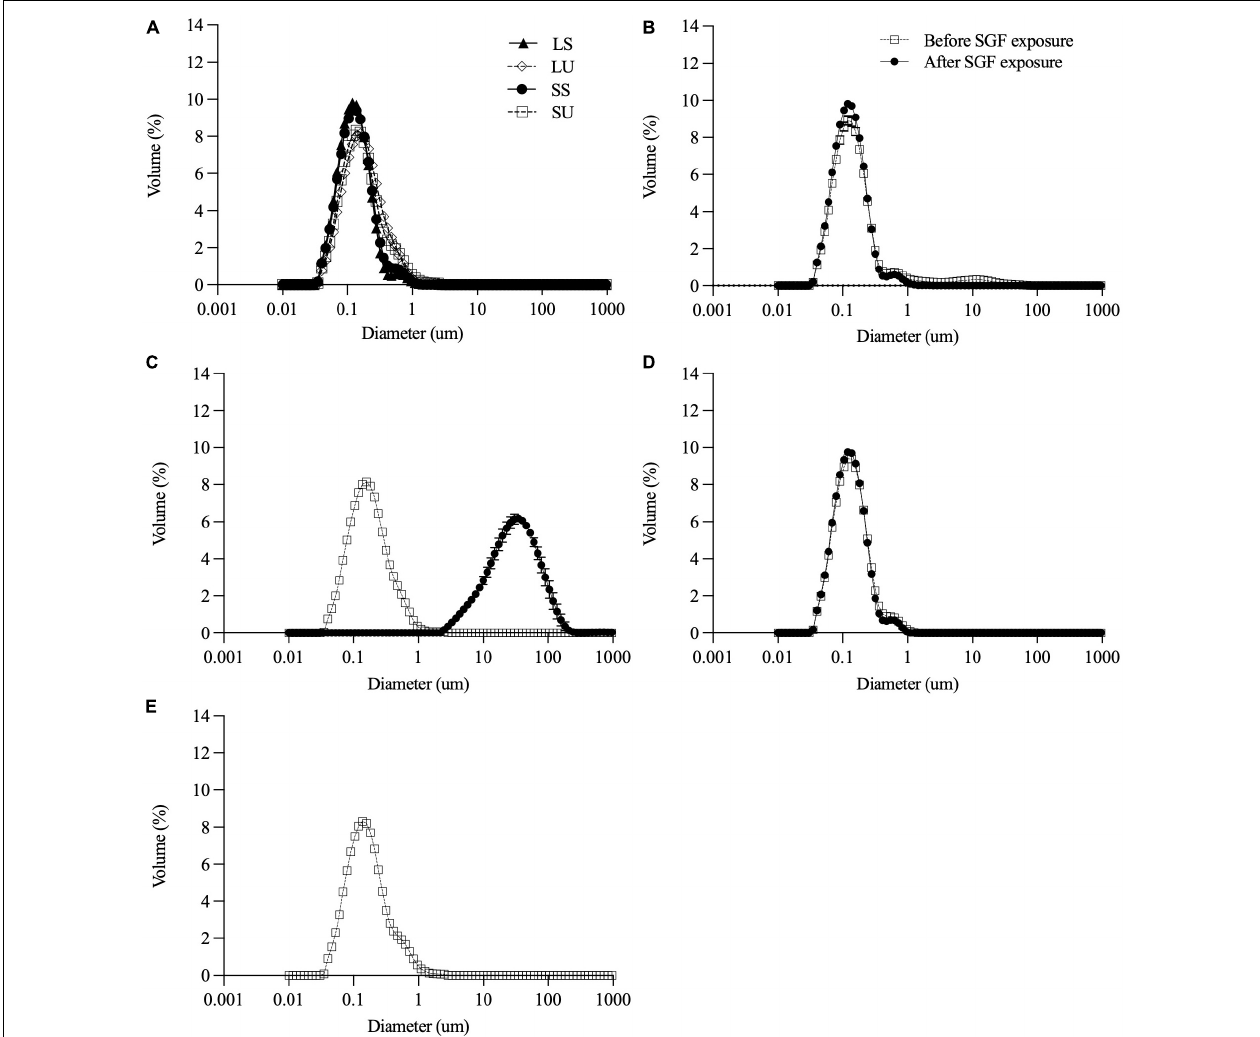
FIGURE 2 | Particle size distribution of all emulsions (A) before digestion and of LS (B) , LU (C) , and SS (D) before and after 2-h exposure to SGF. Particle size distribution before digestion only for SU (E) since measurement after digestion was not feasible due to extensive destabilization. Data reported as mean ± SEM, n = 3. LS, liquid lipid-acid stable emulsifier; LU, liquid lipid-acid unstable emulsifier; SS, solid lipid-acid stable emulsifier; SU, solid lipid-acid unstable emulsifier; SGF, simulated gastric